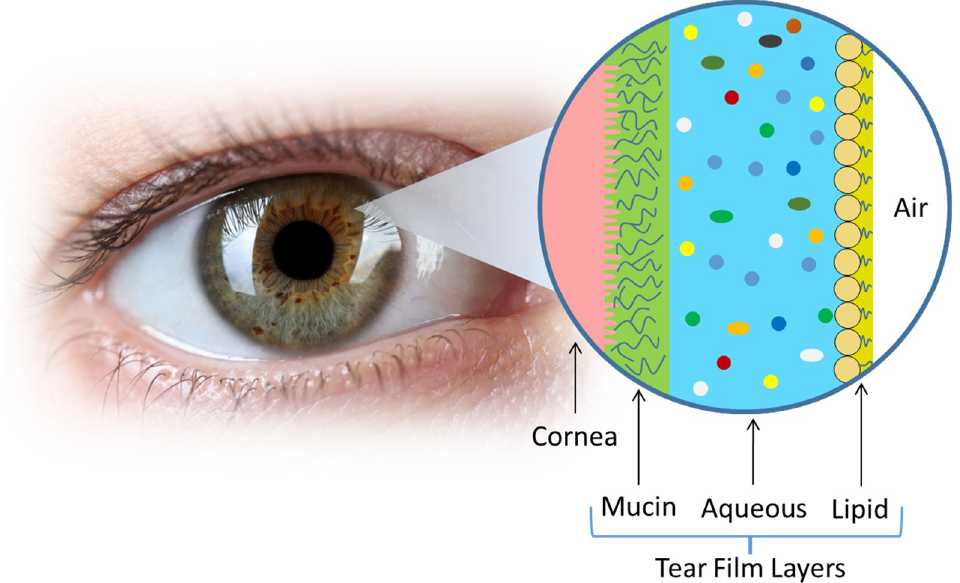
Figure 2. Schematic of the general configuration of human tear film.